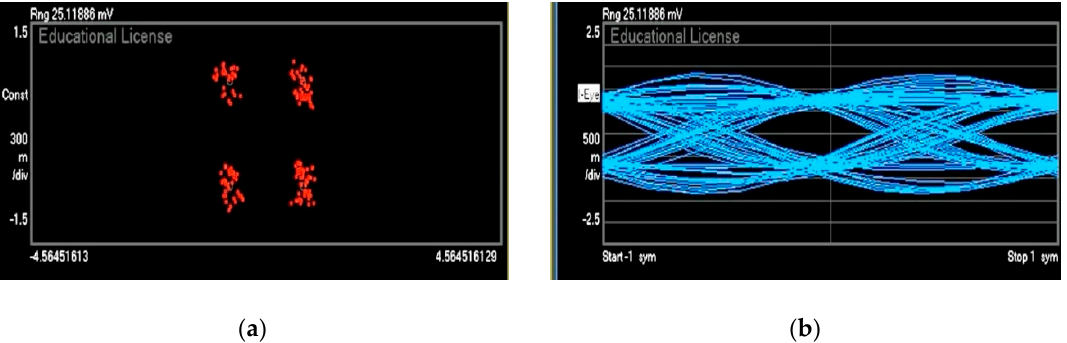
Figure 5. Real-time received QPSK signal reconstruction using VSA code for transmitted 1.5 Vpp PRBS signal. ( a ) IQ constellation and ( b ) eye pattern.